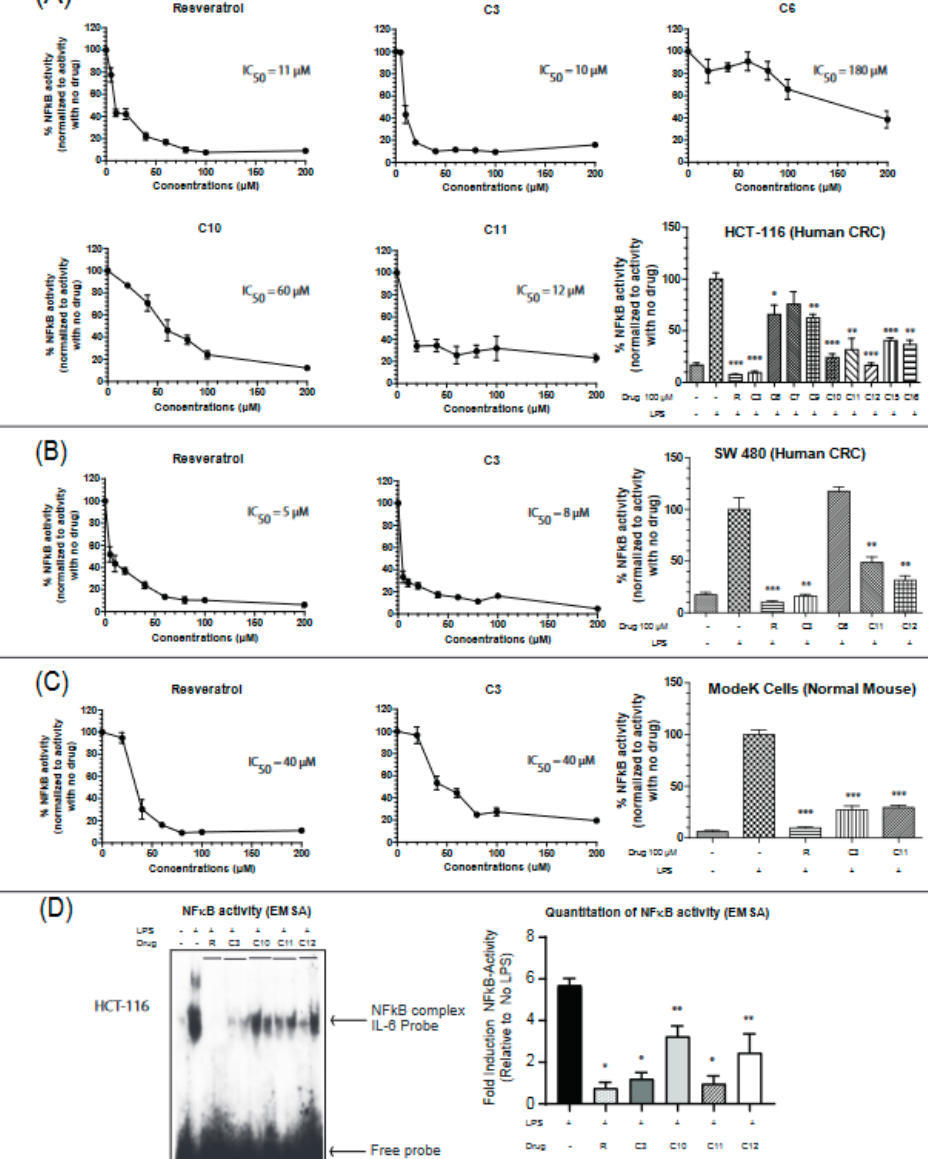
Figure 2. Resveratrol and derivatives inhibit NF κ B activity in colon cancer and normal cell lines. NF κ B activity was determined in ( A ) HCT-116, ( B ) SW 480, and ( C ) ModeK cells by a dual-luciferase assay with firefly luciferase under the control of NF κ B target sequence on IL-6 promoter and Renilla-Luciferase used as an internal control. Cells were treated with drugs for 24 h before being stimulated with lipopolysaccharide (LPS) (1.5 mg/mL) for 4–6 h to ensure NF κ B activation. Normalization was done against LPS-stimulated cells (100% activity). NF κ B activity was determined by the ratio of Firefly-Luc/Renilla-Luc. The concentrations used for IC 50 calculations ranged from 5 µM to 200 µM. The bar graphs show a comparison of the effectiveness of the different drugs at 100 µM. n = 3–8. ( D ) NF κ B activity assessed by binding to the IL-6 promoter sequence DNA using the electrophoretic mobility shift assay (EMSA) technique. HCT-116 cells were grown to 60% confluency, treated with drugs for 24 h, and then stimulated with LPS (1.5 mg/mL) for 4 h in serum-free media. Two µg nuclear extracts were incubated with duplex DNA specific to NF κ B (in duplicate). N = 4–6 * p -value < 0.0001, ** p -value < 0.003. If not stated, p -value > 0.05. For ( D ), p -value comparisons were made with respect to LPS-treated cells.